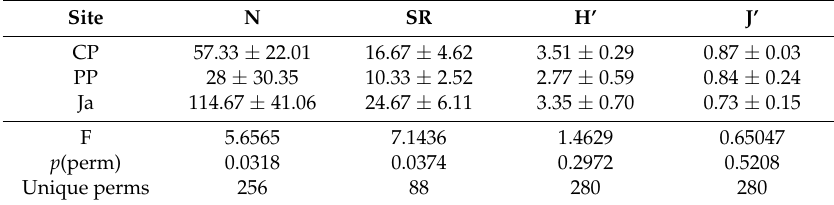
Table 3. Mollusc assemblage. Number of individuals (N) per dm 2 , species richness (SR) and diversity indices (H’, J’) measured for the three sampled sites (CP Cabo de Palos, PP Punta Prima and Ja J á vea) (mean ± SD), and results of PERMANOVA test on Euclidean distance (F: F-value, p (perm): calculated probability value, Unique perms: the number of unique permutations).